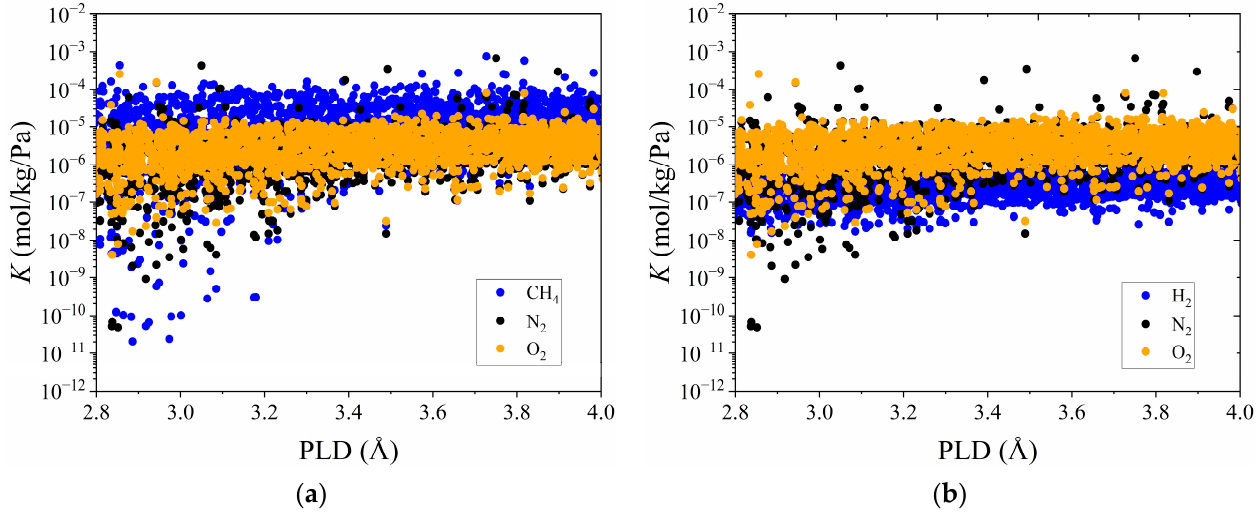
Figure 1. ( a ) Henry’s constant K vs. PLD for CH 4 , N 2 , and O 2 in 6013 CoRE-MOFs; ( b ) Henry’s constant K vs. PLD for H 2 , N 2 , and O 2 in 6013 CoRE-MOFs.